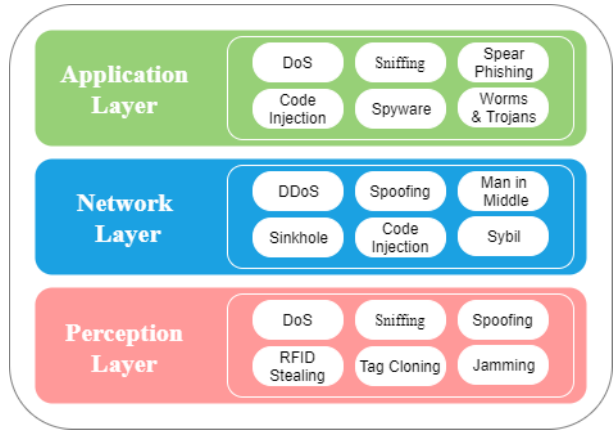
Figure 2. Attacks on IoT Layers.